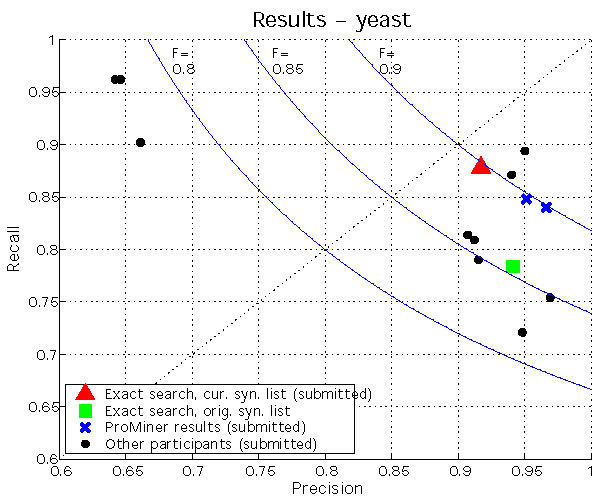
Yeast results. BioCreAtIvE task 1B results for yeast and the impact of curation of the synonym list. The submitted result was obtained with the fully curated synonym list.